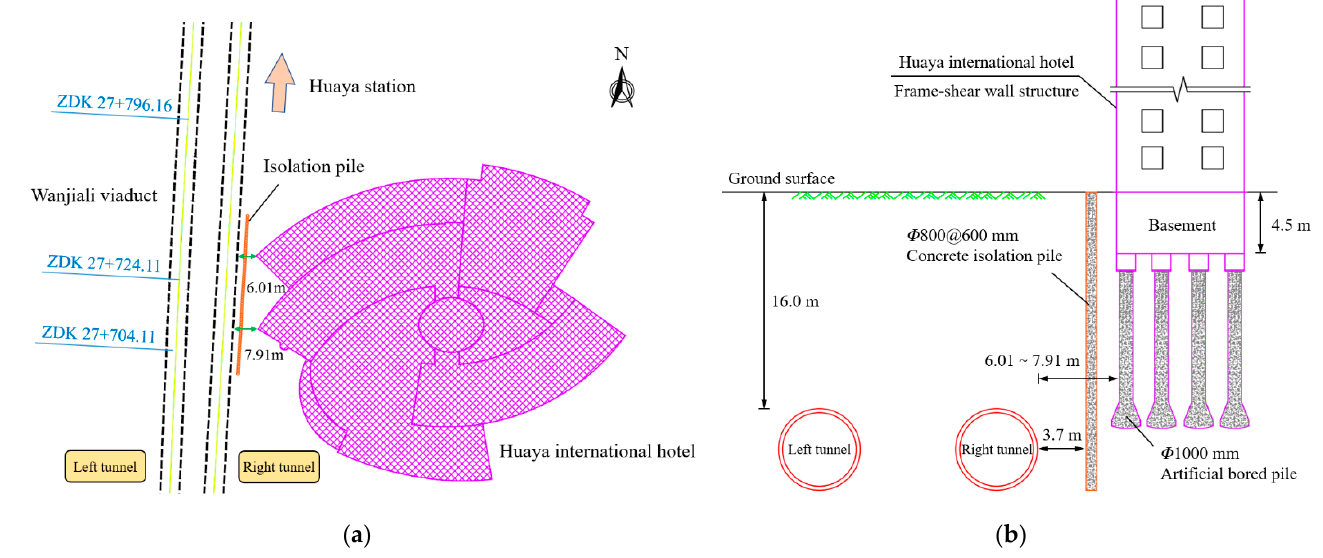
Figure 3. Relationship among building, isolation pile, and tunnel: ( a ) top view and ( b ) sectional